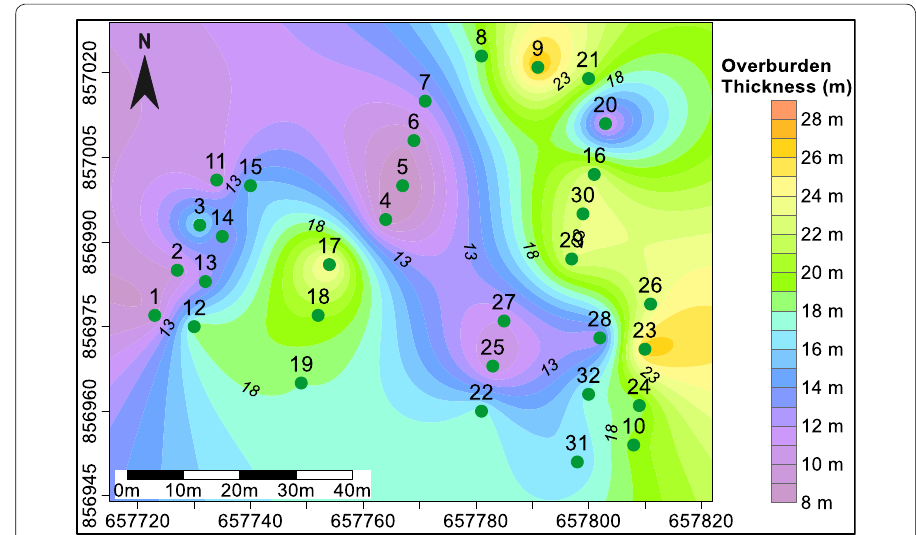
Fig. 12 Isopach map showing the overburden thickness distribution